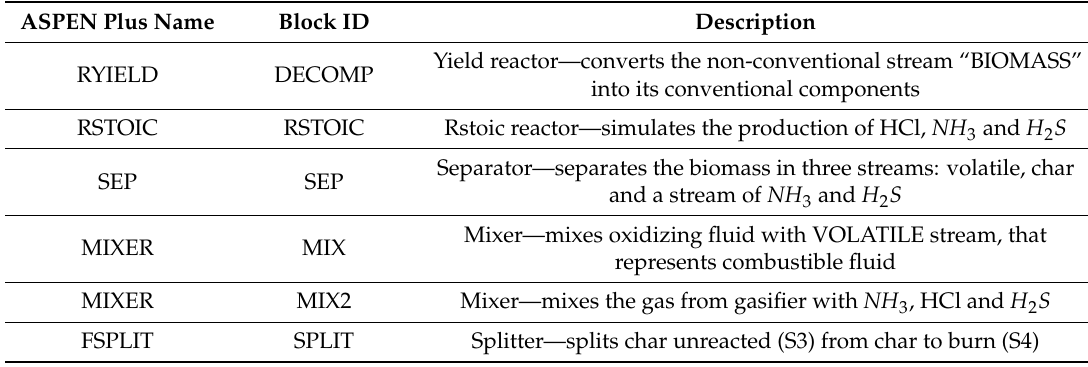
Table 5. Description of ASPEN Plus flowsheet unit operation presented in Figure